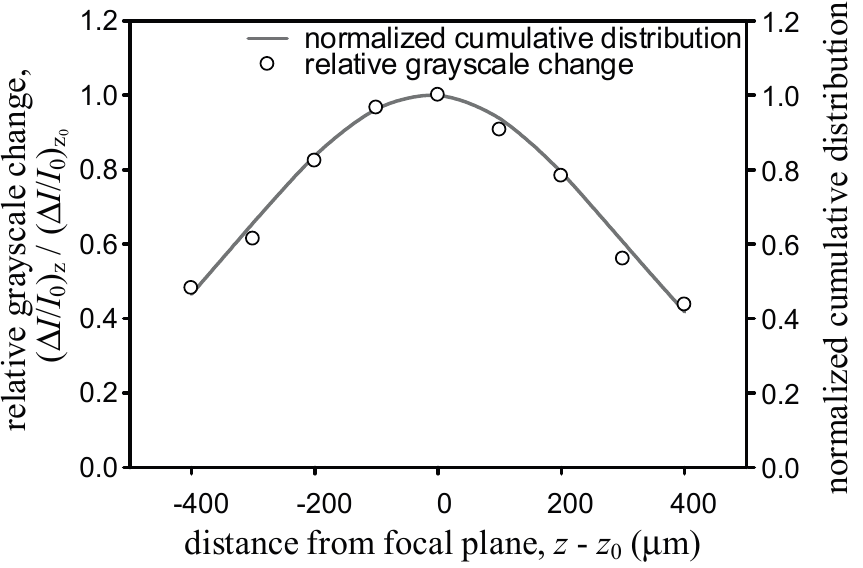
Figure 4. Comparison of relative grayscale change to the normalized cumulative distribution for the 5×